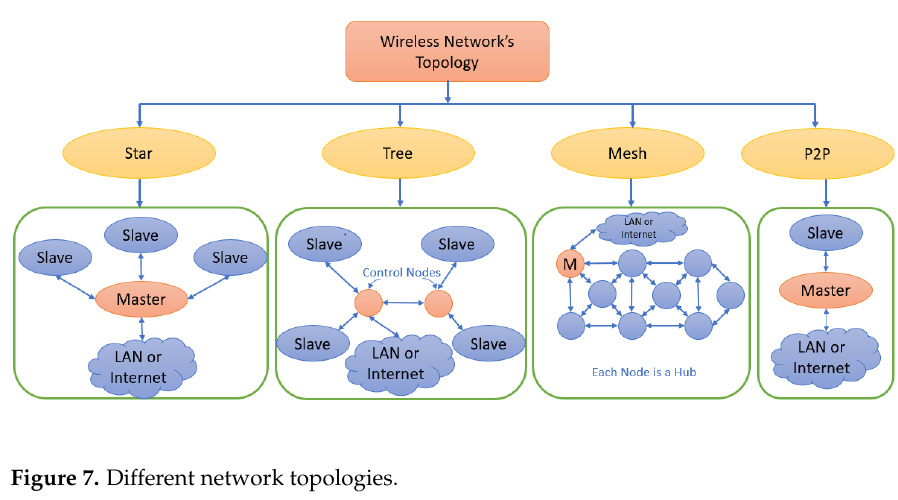
Figure 6. Comparing Bluetooth BR/EDR and BLE stacks with OSI stack.